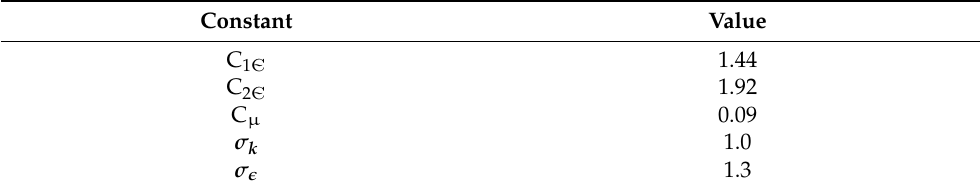
Table 2. Model constants.